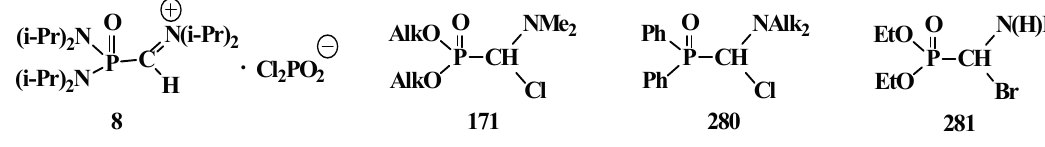
Figure 6. Representatives of phosphorylated Vilsmeier–Haak reagents 8 , 171 , 280 , 281 synthesized to